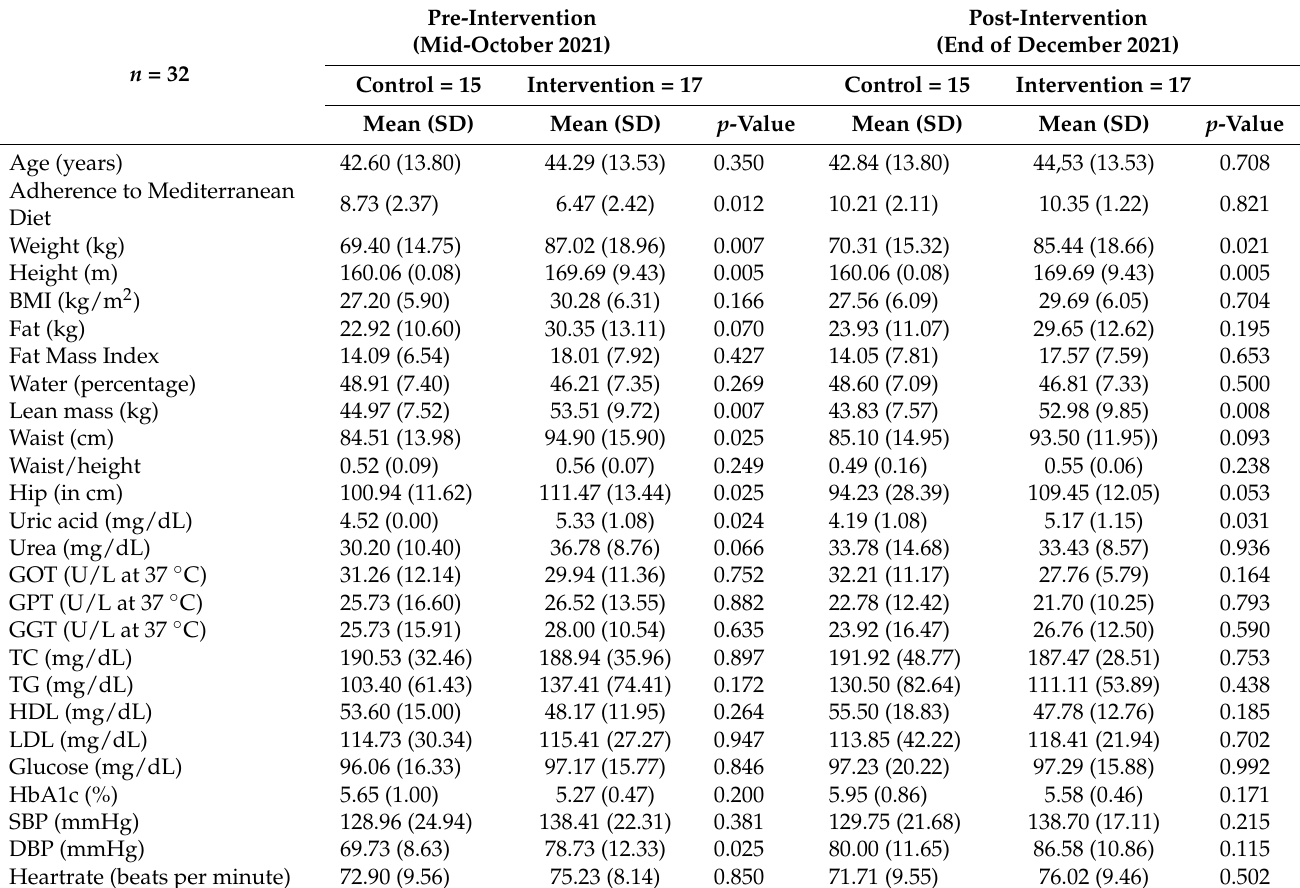
Table 3. Mean and SD values of main parameters before and after the intervention